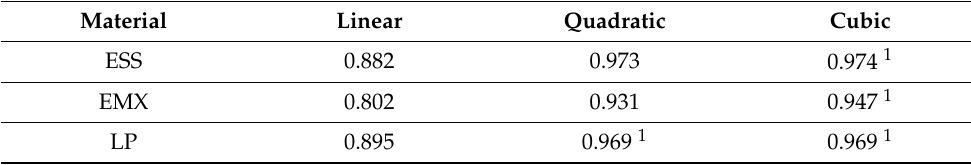
Figure 6. Regression curves of the fracture load values for the Lava Plus HT A2 (LU), with specimens in the five different material thicknesses examined. Table 3. R 2 values of the linear, quadratic, and cubic regression